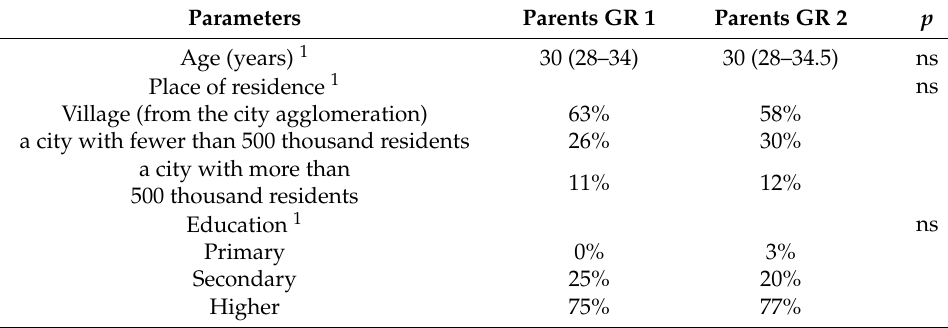
Table 1. Data concerning parents’ age, education, and place of residence.